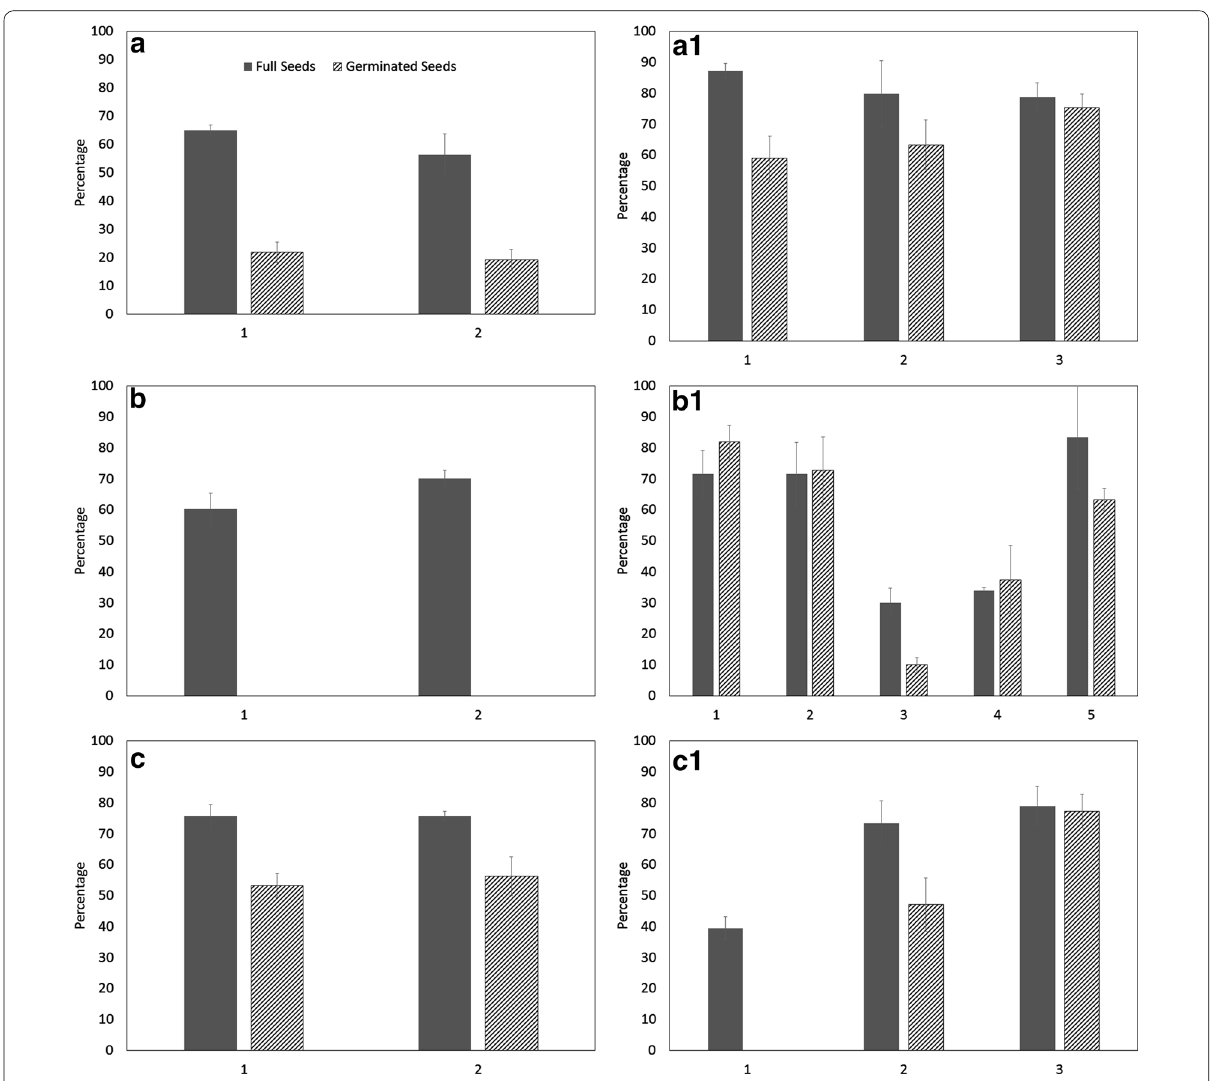
Fig. 3 Percent full seed and seed germination after 6 months for seeds from mature capsules ( letter ) and seeds from in vitro collected near-mature capsules ( letter 1 ) seeds. a , a1 Angraecum magdalenae ; b , b1 Angraecum calceolus ; c , c1 Angraecum rutenbergianum ; Bar numbers refer to mature + and in vitro collected seed capsule numbers. Means of four replicates standard ±